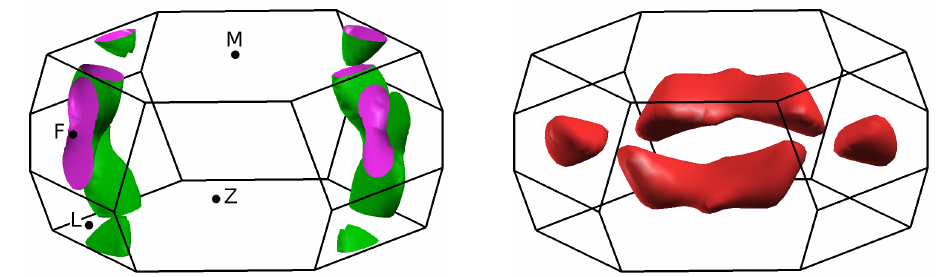
Figure 8: Left: Calculated Fermi sheets of LaNiO romagnetic R -type phase.